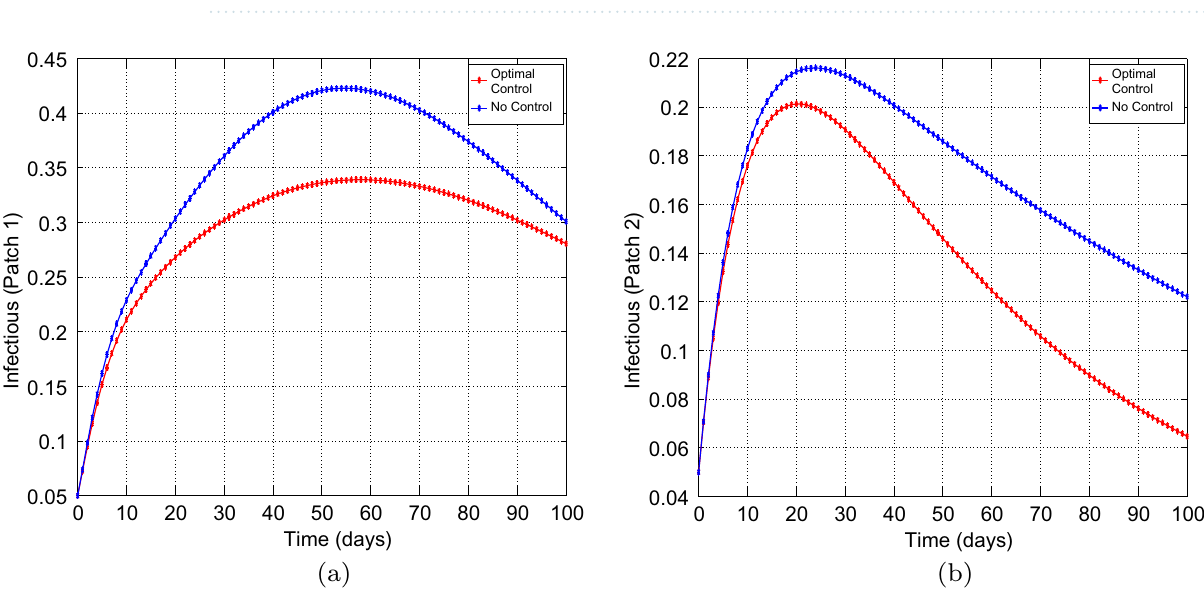
Figure 5. Simulation outcomes for the presented two patch COVID-19 mathematical model for case 1 under asymmetric strong coupling ( a ) the number of infected humans in patch 1 ( b ) the number of infected humans in patch 2. In both figures, the red curves and blue curves are for the infected population, with optimal control and no optimal control